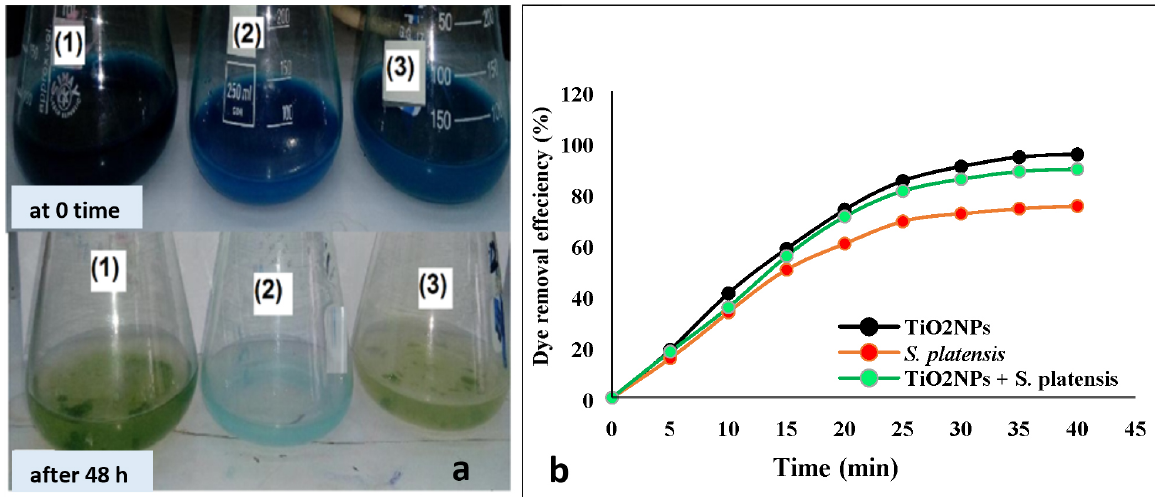
Figure 5. (a) Photo of the three treatments: (1) S. platensis culture suspension with MG, (2) S. paucimobilis TiO with MG, and (3) S. platensis + TiO NPs with MG at 0 time and after 48 h. (b) Efficiency (%) of different biosorbent 2 treatments on MG removal at constant concentration of 1x10 3 mol/L, at 30 o C after 48 h incubation